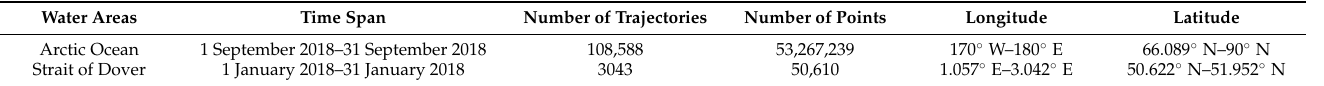
Table 1. The data details for the two research study areas.